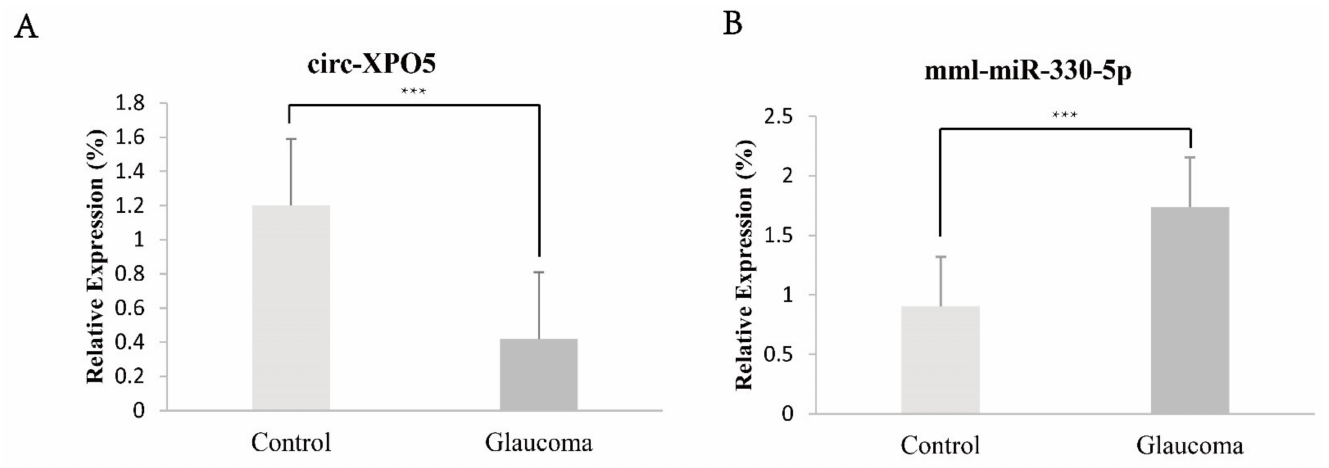
Figure 5. Prediction of miRNAs between candidate circRNAs and GRIN2A. ( A – D ) Predicted miRNAs for 4 candidate circRNAs.